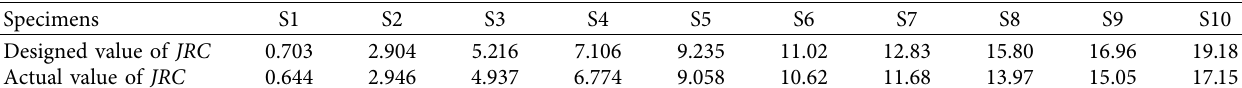
Figure 3: Jointed specimens with different JRC. Table 1: The difference between the actual and designed values of JRC .